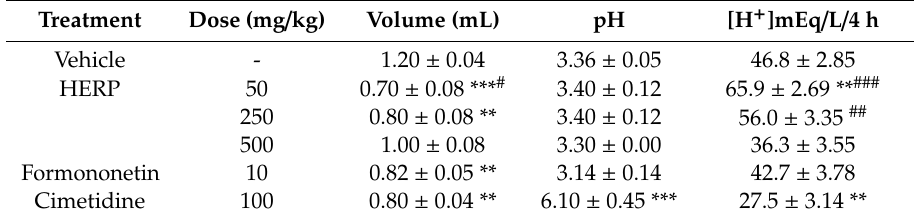
Table 3. E ff ects of intraduodenal treatments with HERP and formononetin on the biochemical parameters of gastric juice collected from the pylorus ligature rats.